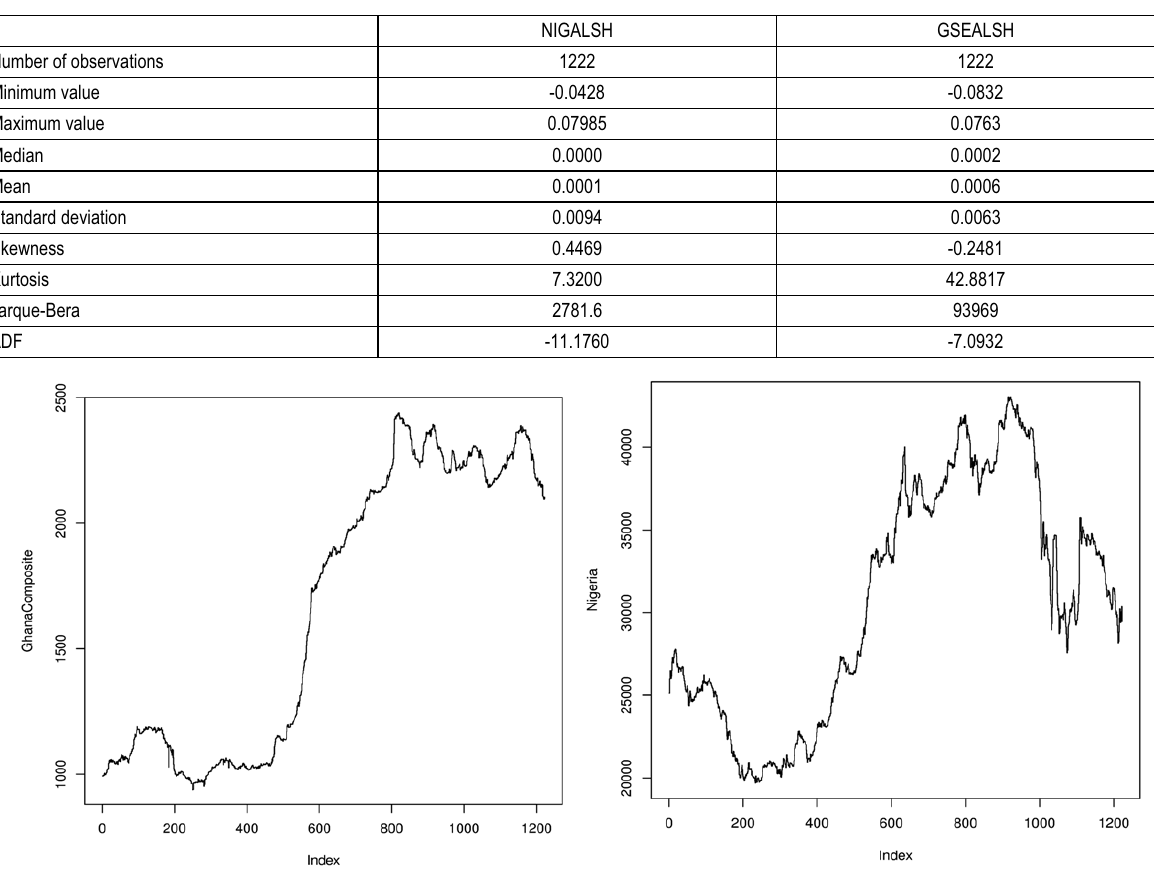
Fig. 1. Plot of daily price index for Ghana and